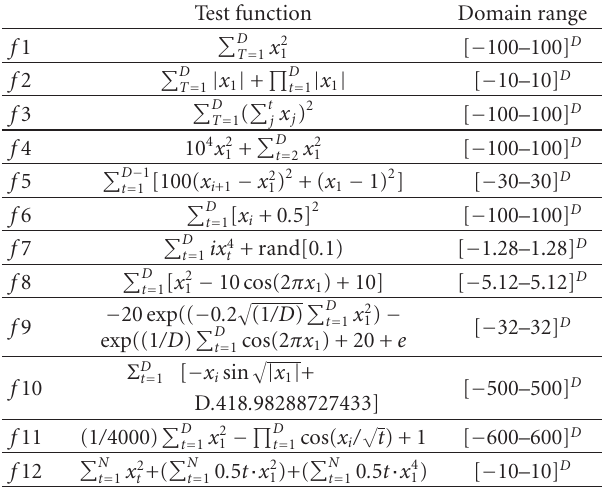
Table 1: Benchmark test functions of dimension D . Test functions each of them has a global minimum value of